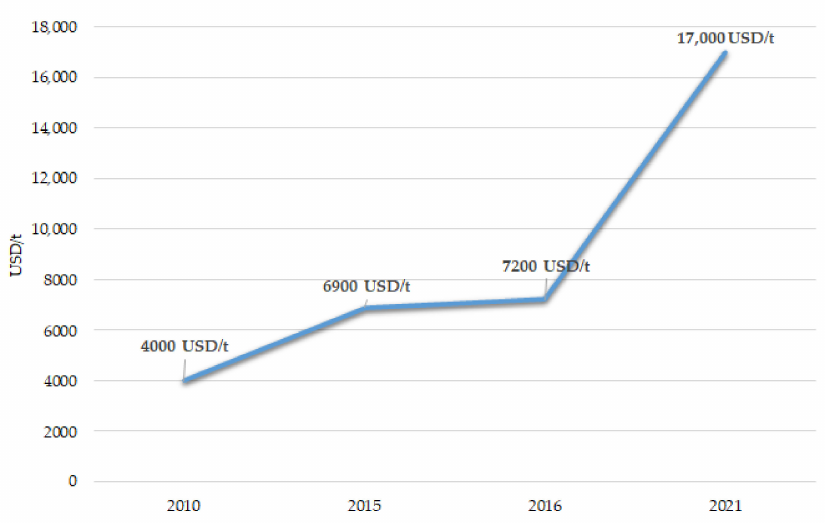
Figure 3. Lithium carbonate price (2010 to 2021)